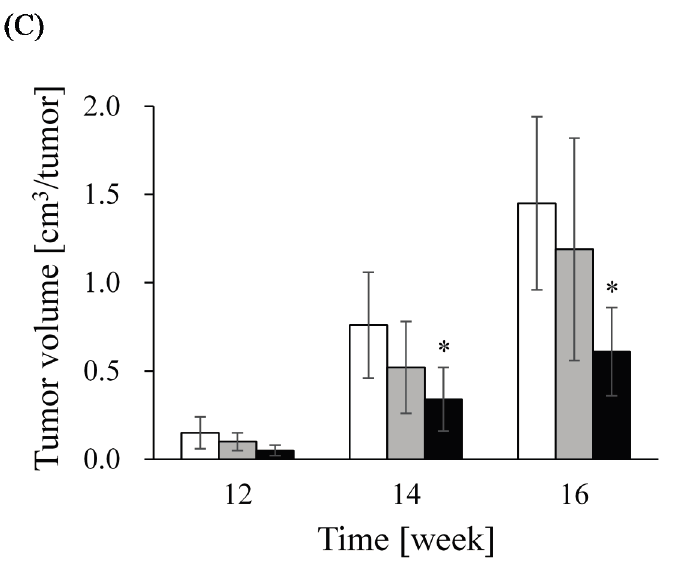
Figure 2. Time course changes in palpable mammary tumors in PhIP-exposed rats in 12th, 14th and 16th week after the start of the experiment. ( A ) Tumor incidence; ( B ) multiplicity; and ( C ) tumor volume. White bar, control; gray bar, soy milk and black bar, fermented soy milk beverage. All the data were expressed as the mean ± SE. The tumor incidence was analyzed using the χ 2 test. The tumor multiplicity and volume were analyzed using the Dunnett test relative to the control group [52]. * p < 0.05; ** p < 0.01. Kaga C. et